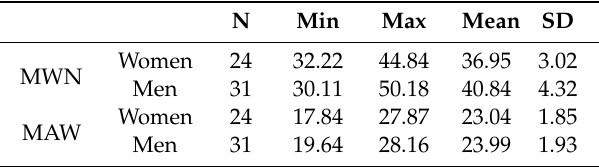
Table 2. Descriptive statistics of the maximum width of the nose (MWN) and the maximum width of the nasal aperture (MAW) separately for males and